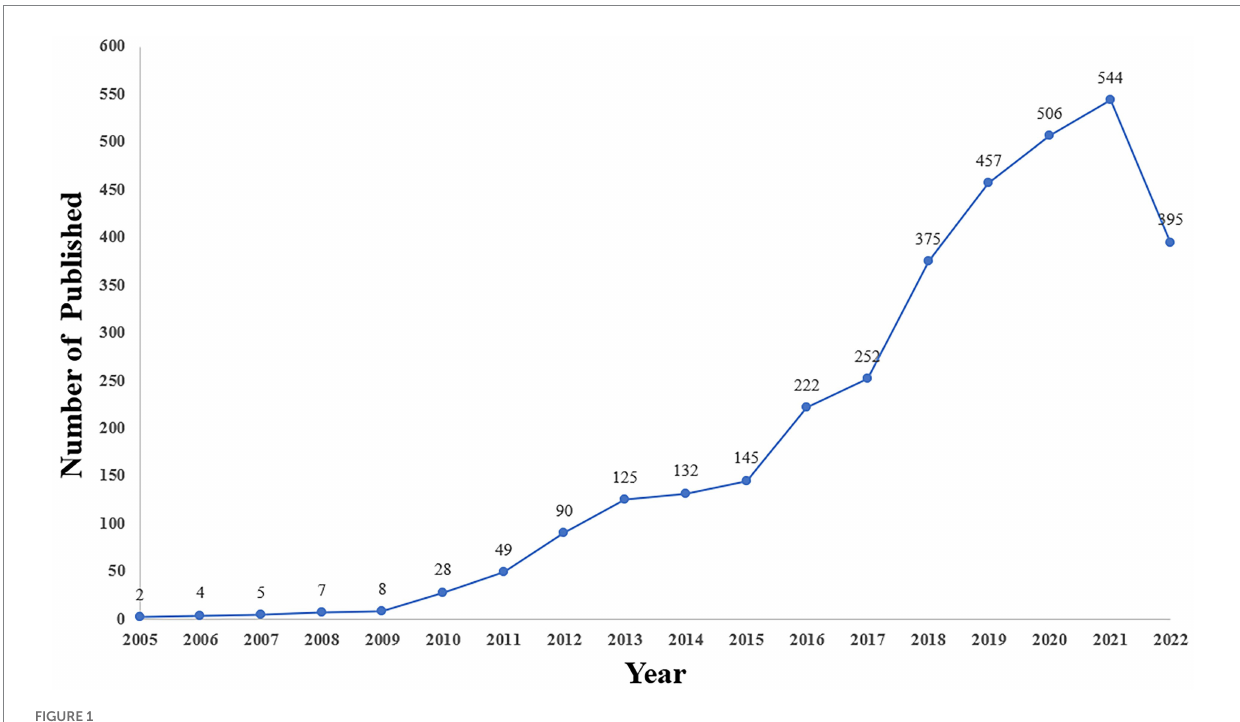
FIGURE 1 Annual trend chart of